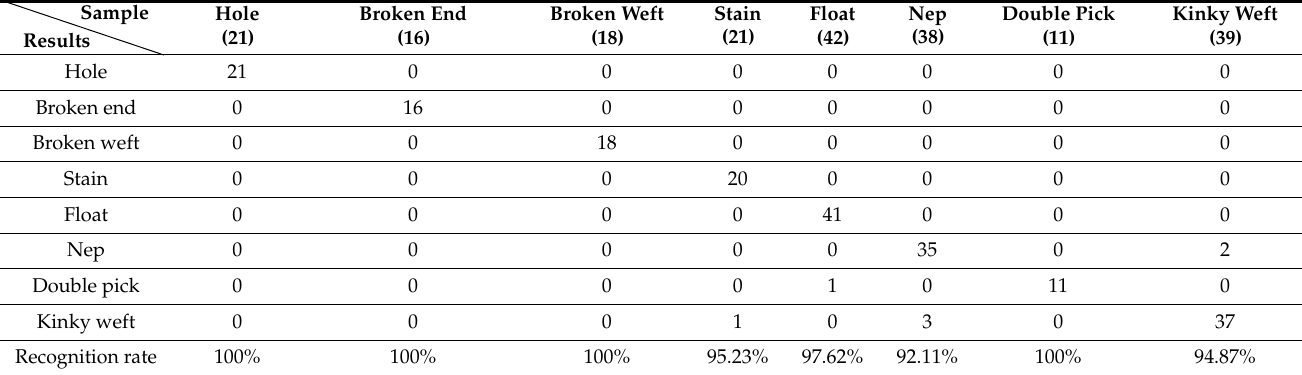
Table 1. Identification results of support vector machines.